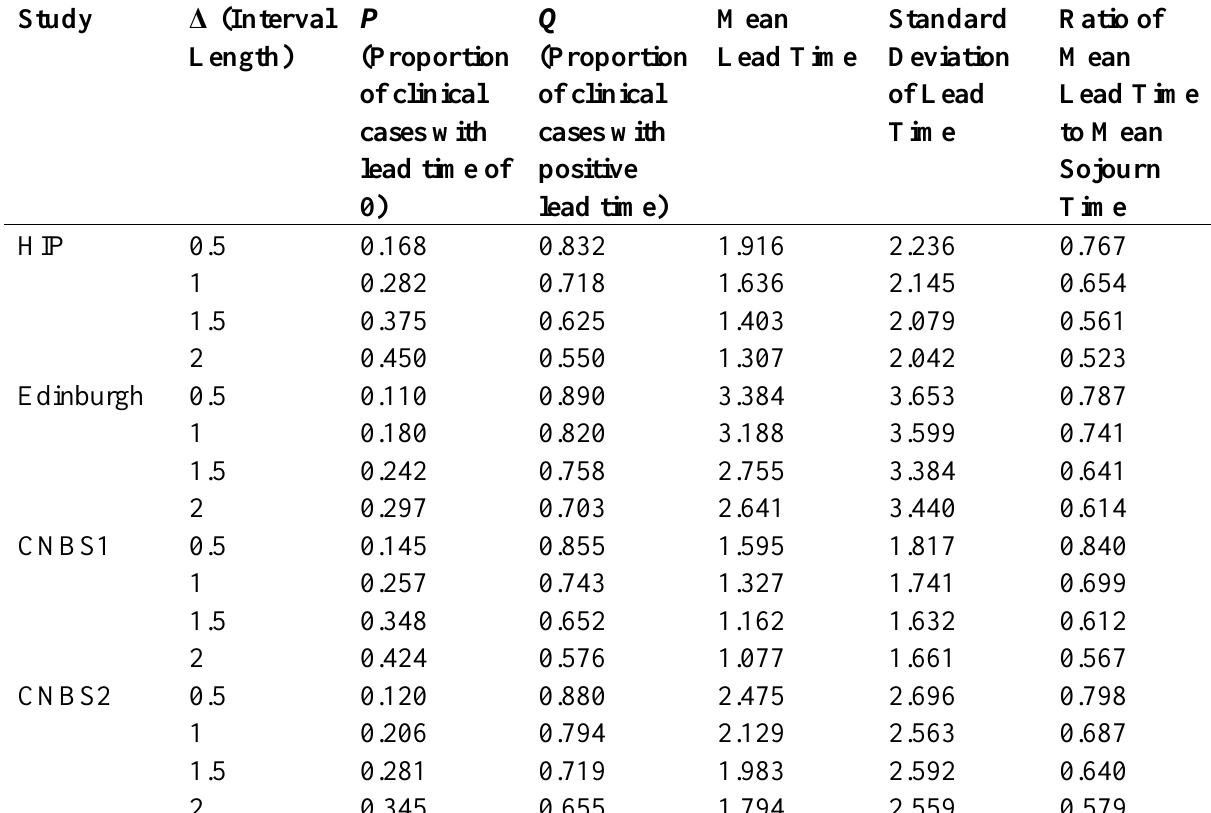
Table 2. Lead time estimates for the four screening trials.